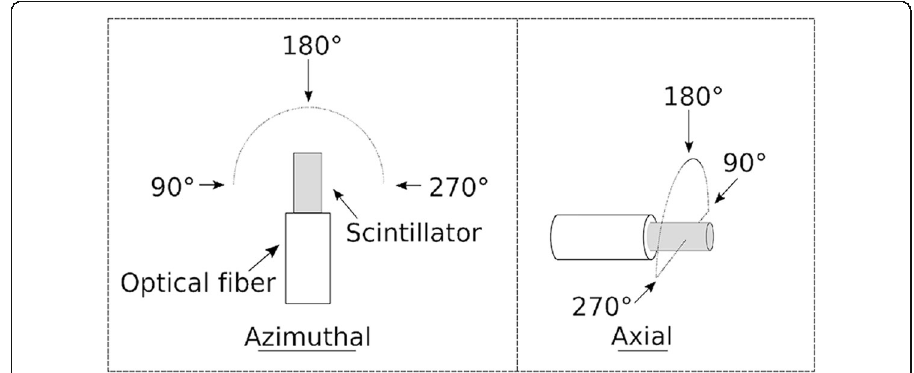
Fig. 11 The schematic of the angler dependence measurement showing the azimuthal angular change and the axial angular change [59]. The arrows by the angle 90°, 180°, and 270° give the direction of incident